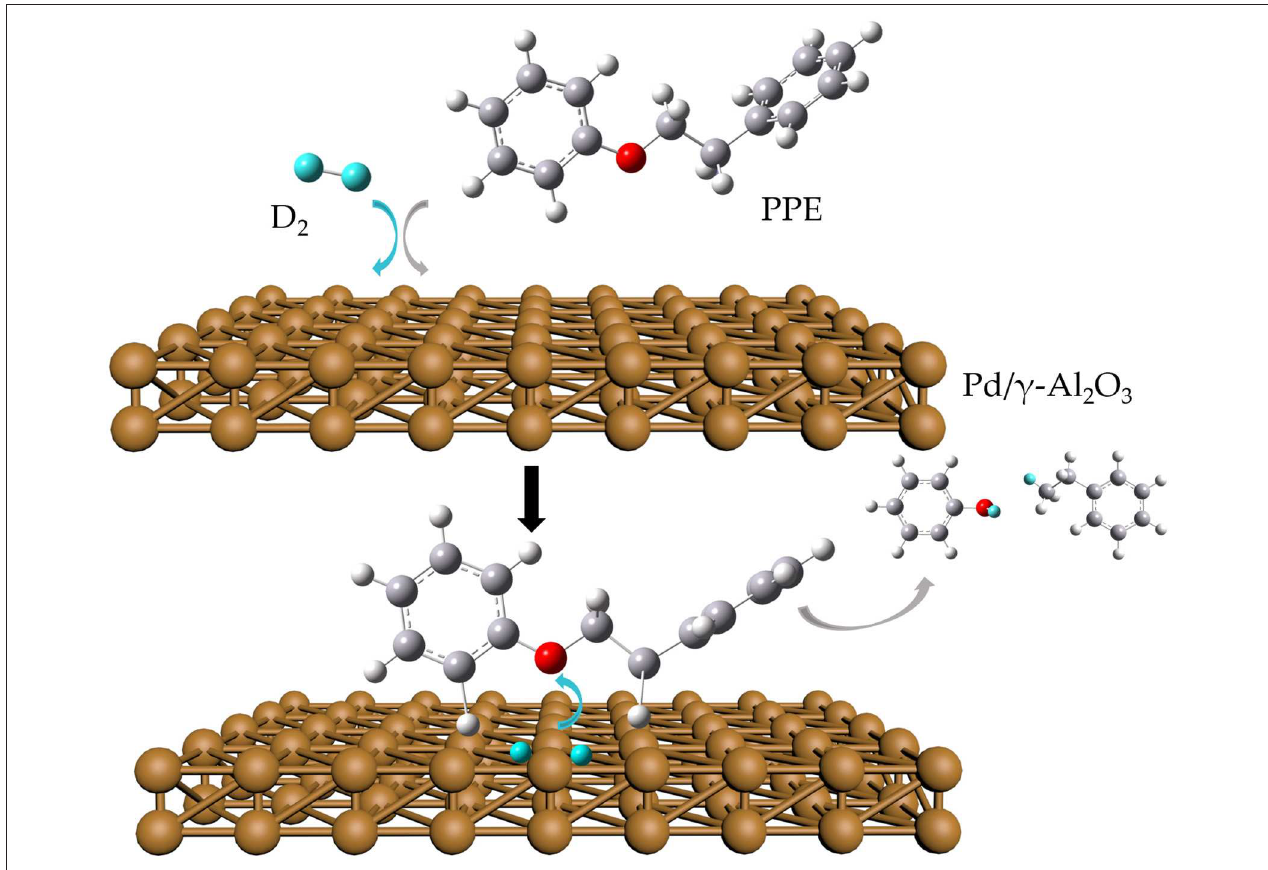
FIGURE 4 | Possible cleavage mechanism of PPE Pd/ γ -Al 2 O 3 .